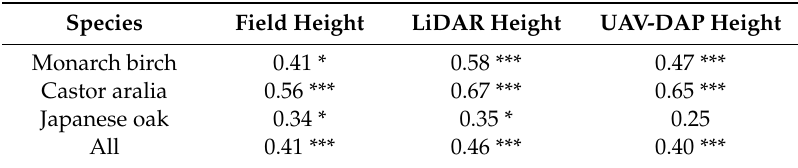
Table 6. Pearson’s correlation coefficient between tree height and DBH.